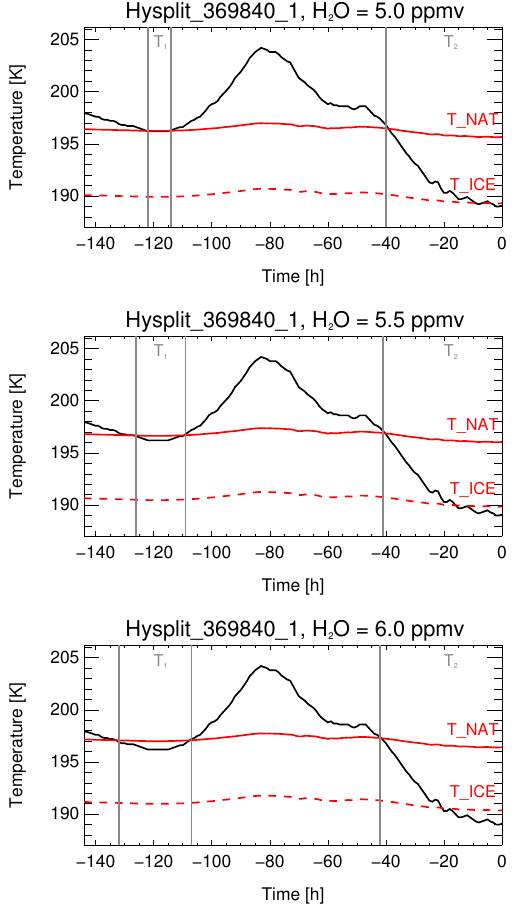
Figure 6. Same as Fig. 5 but with an additional temperature de- crease along the back trajectory of